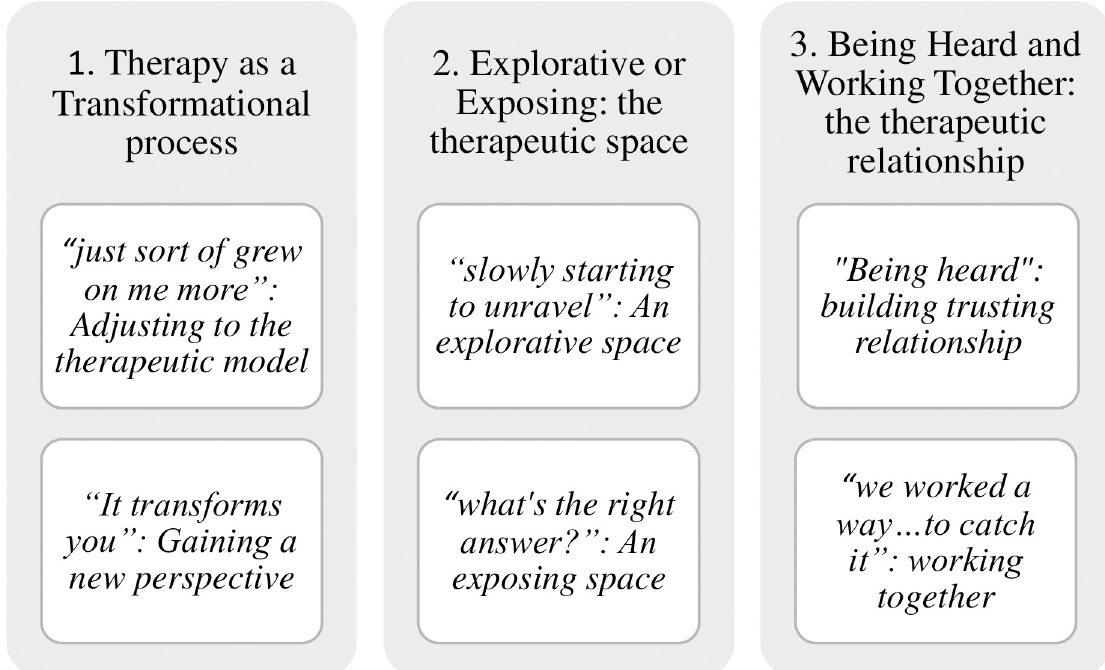
Fig 1. Description of superordinate and subordinate themes encapsulating adolescents’ experience of STPP.